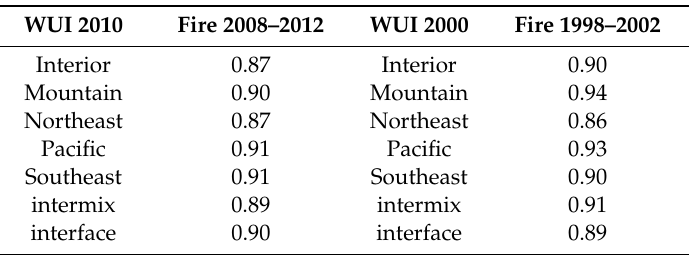
Table 2. Sensitivity (true positive rate) of predictions for the C5.0 classifier at 0.67 prevalence from modeled training data of fire occurrences during 2008–2012 in WUI during 2010 and fire occurrences during 1998–2002 in WUI during 2000 by region and WUI type.